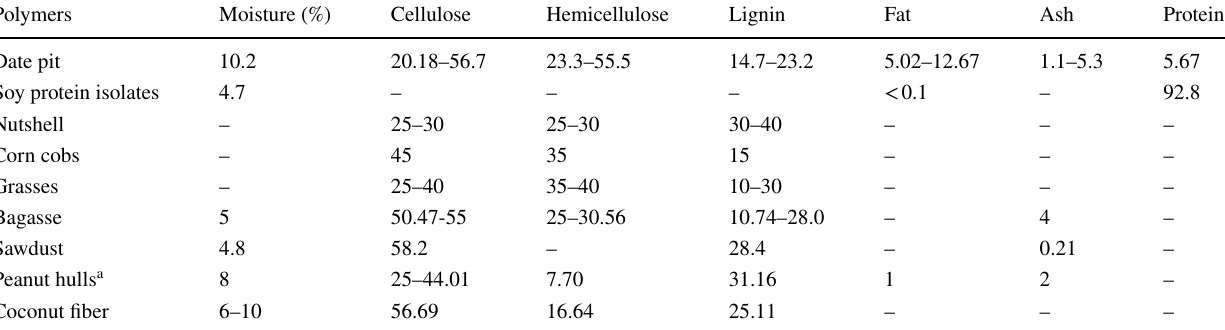
Table 2 Average composition of lignocellulose materials (Gandini 2008; Singh et al. 2008; Adewole and Sultan 2013; Fiorelli et al. 2014; Aboulrous et al. 2016)